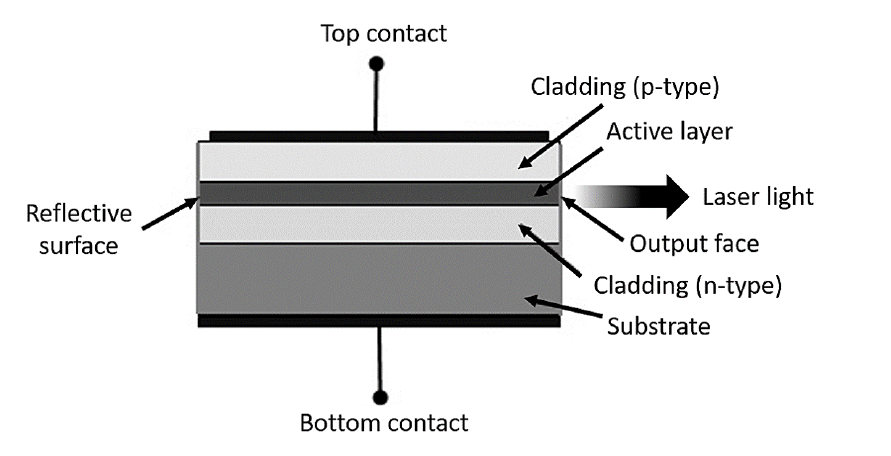
Figure 11. Schematic diagram of a edge-emitting (EEL) diode laser.